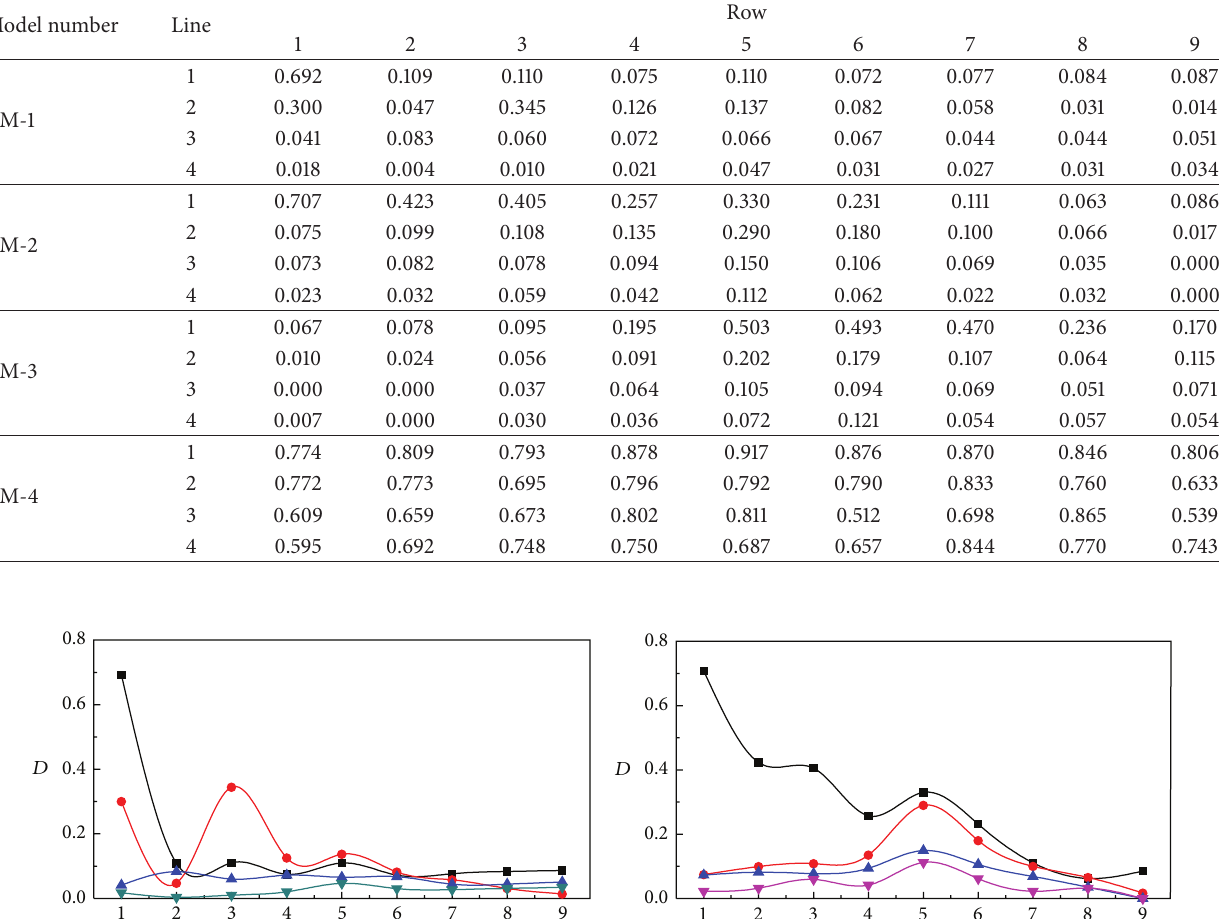
Table 3: Blast-induced damage factor in concrete model with three-circle blastholes.